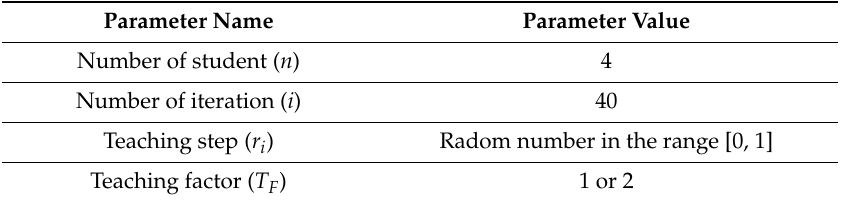
Figure 4. Output power–voltage (P–V) characteristic curves of photovoltaic module array with different numbers of shaded panels. Table 4. Parameter values of teaching learning based optimization algorithm.